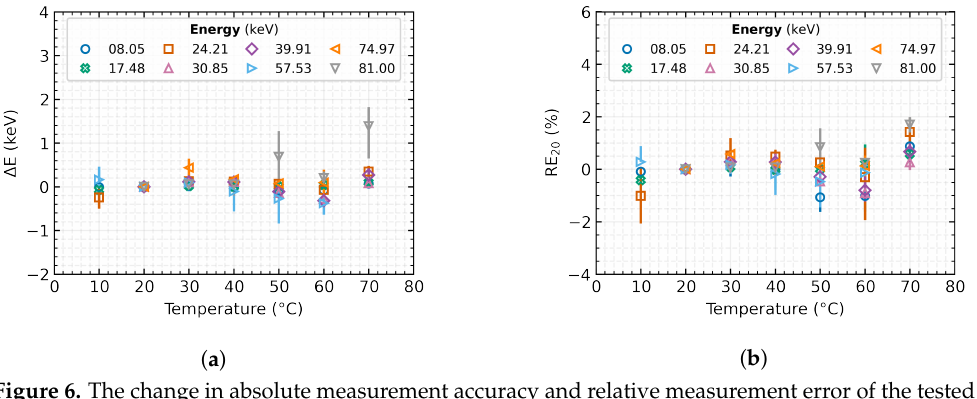
Figure 6. The change in absolute measurement accuracy and relative measurement error of the tested sources after applying the proposed correction. The plotted data represent the mean values over the tested detectors, and the error bars indicate their minimum and maximum value: ( a ) Absolute measurement accuracy; ( b ) Relative error of